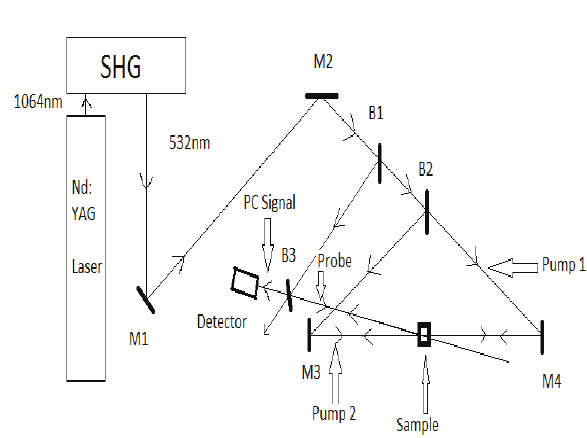
Figure 2: Degenerate Four Wave